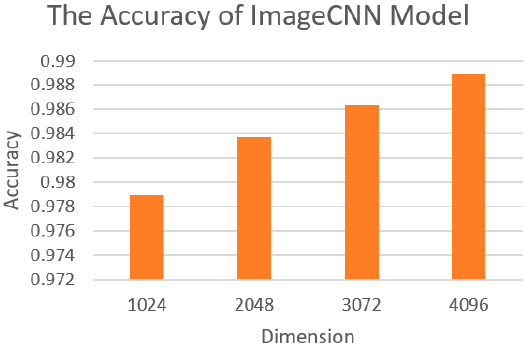
Figure 7. The accuracy of the ImageCNN model.